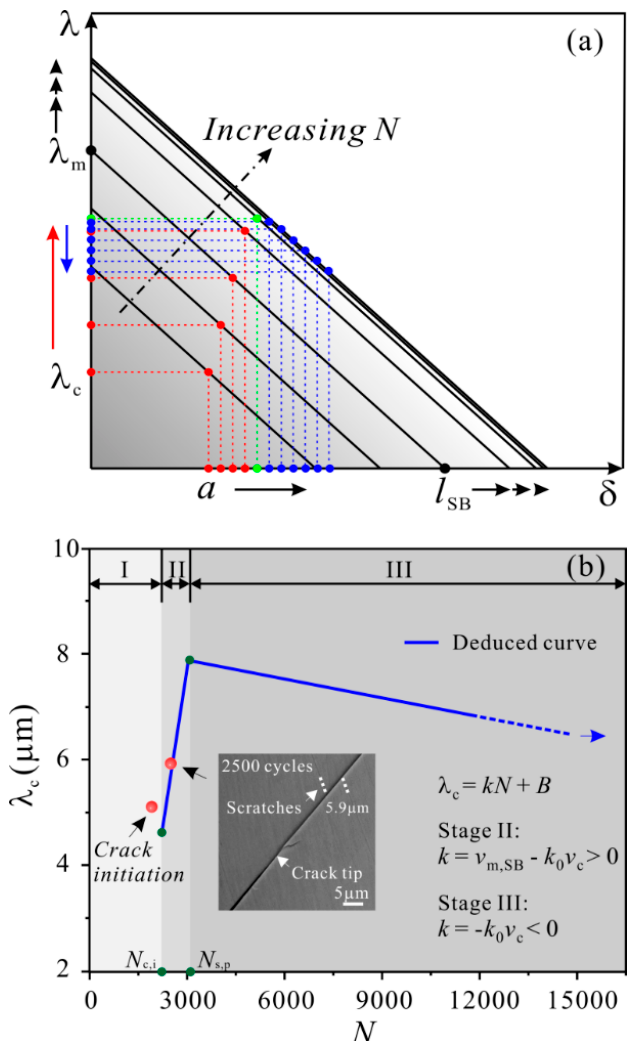
Figure 10. ( a ) Schematic illustrations of λ as a function of δ under different cycles, showing the detailed derivation process of λ c ; ( b ) plot of λ c as a function of N [48].